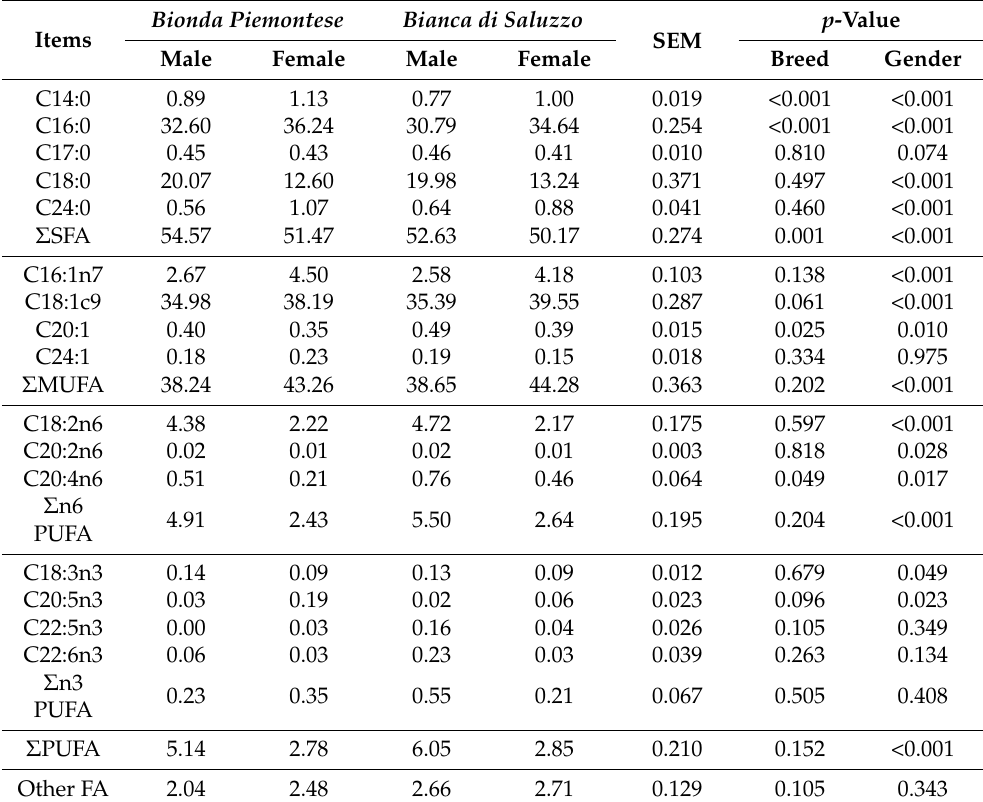
Table 7. Average fatty acid profile of thigh meat (g/100 g of total detected fatty acids) of Bionda Piemontese and Bianca di Saluzzo breeds. Data are the average of the four consecutive slaughtering at 5, 6, 7, and 8 months of age ( n = 32).